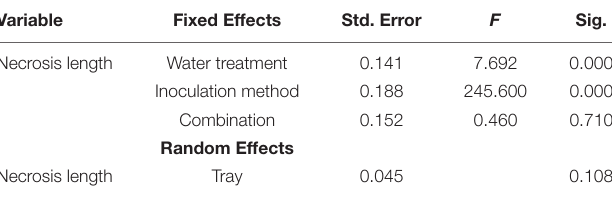
TABLE 5 | The General Linear Model values.